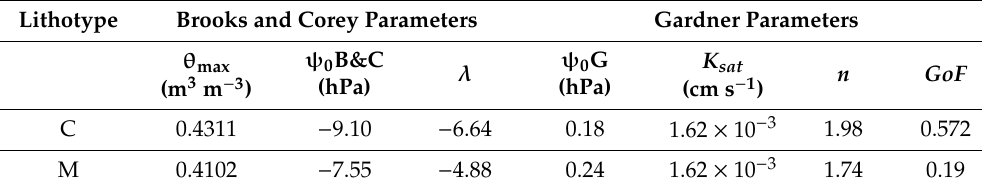
Table 4. The fitting parameters used for the curves in Figures 5 and 6. θ max is the maximum water content measured by the QSC, ψ 0 is the air-entry value, and λ is the pore distribution index, K sat is the saturated hydraulic conductivity, n is an empirical parameter, and GoF is the root mean square goodness of fit. The parameters were obtained by the KOPCEN code